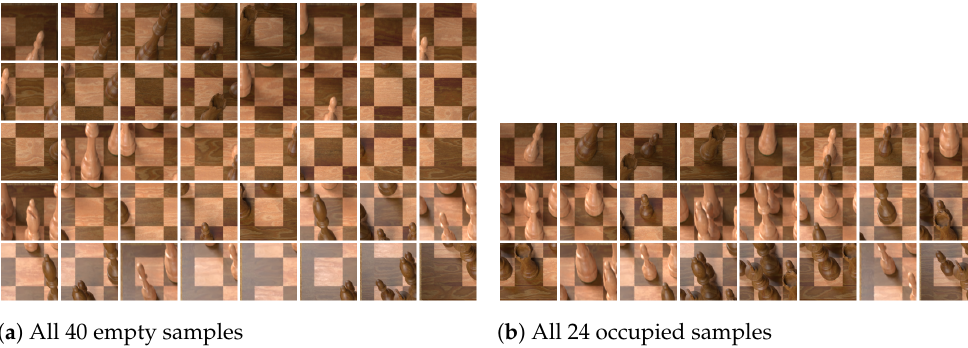
Figure 6. Samples for occupancy classification generated from the running example chessboard image. The squares are cropped with a 50% increase in width and height to include contextual